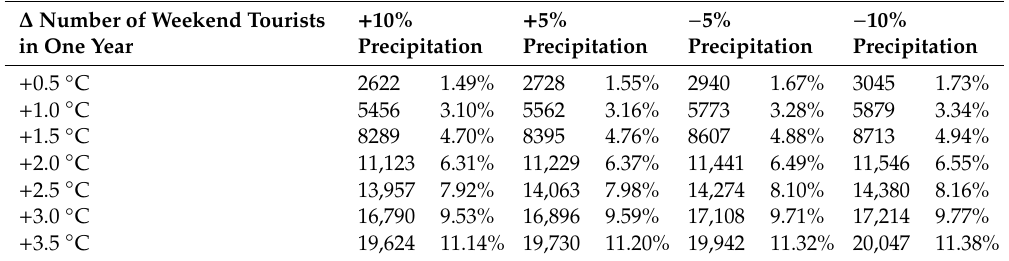
Table 13. Number of weekend tourists increase in one year (persons per season) and increate rate